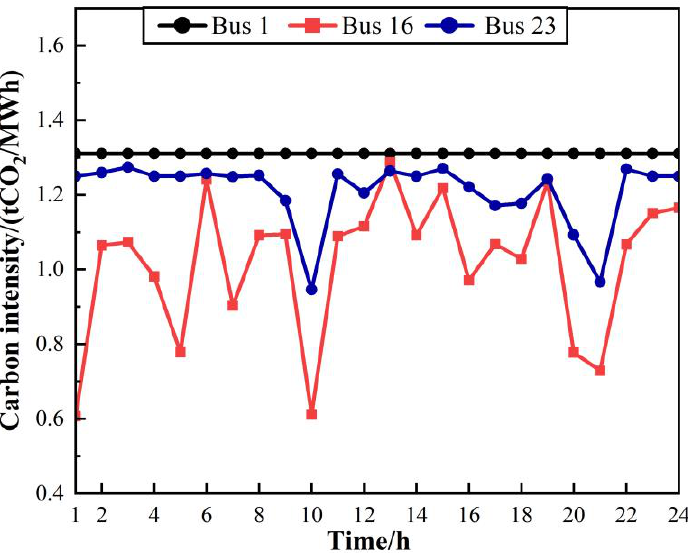
Figure 6. Bus carbon intensities at optional WT locations before planning.